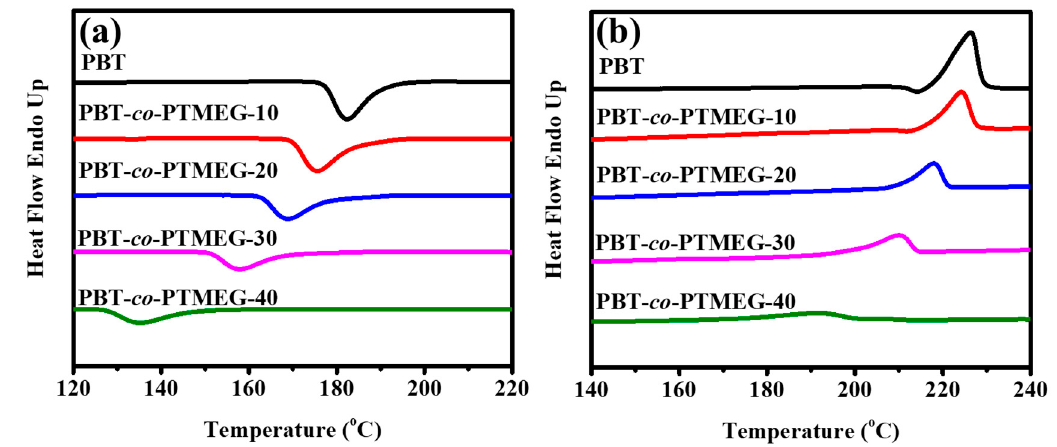
Figure 3. DSC curves of PBT and PBT- co -PTMEG copolymers in ( a ) 1st cooling process and ( b ) 2nd heating process at a rate of 10 °C min − 1 . Table 2. Thermal properties of PBT and PBT- co -PTMEG copolymers.